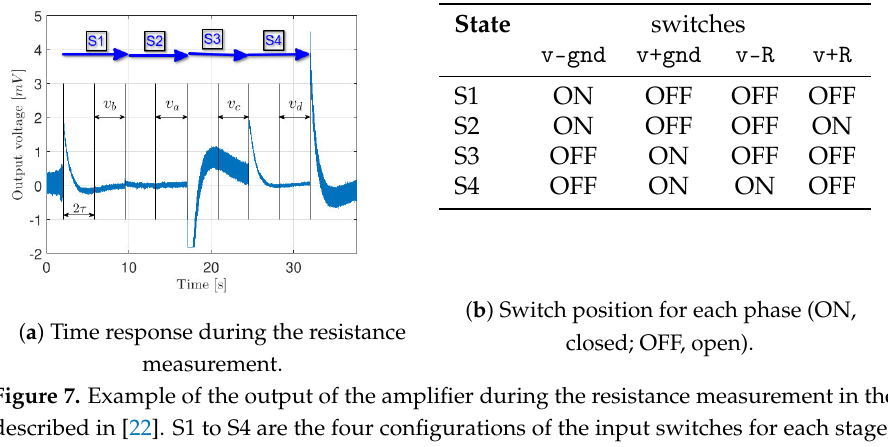
Figure 8. Example of the output voltage from the prototype for R + = 5k Ω and R switching every 400ms. The base signal is a 100Hz sinusoidal one; it is evident that the transients are fast when the control voltage is